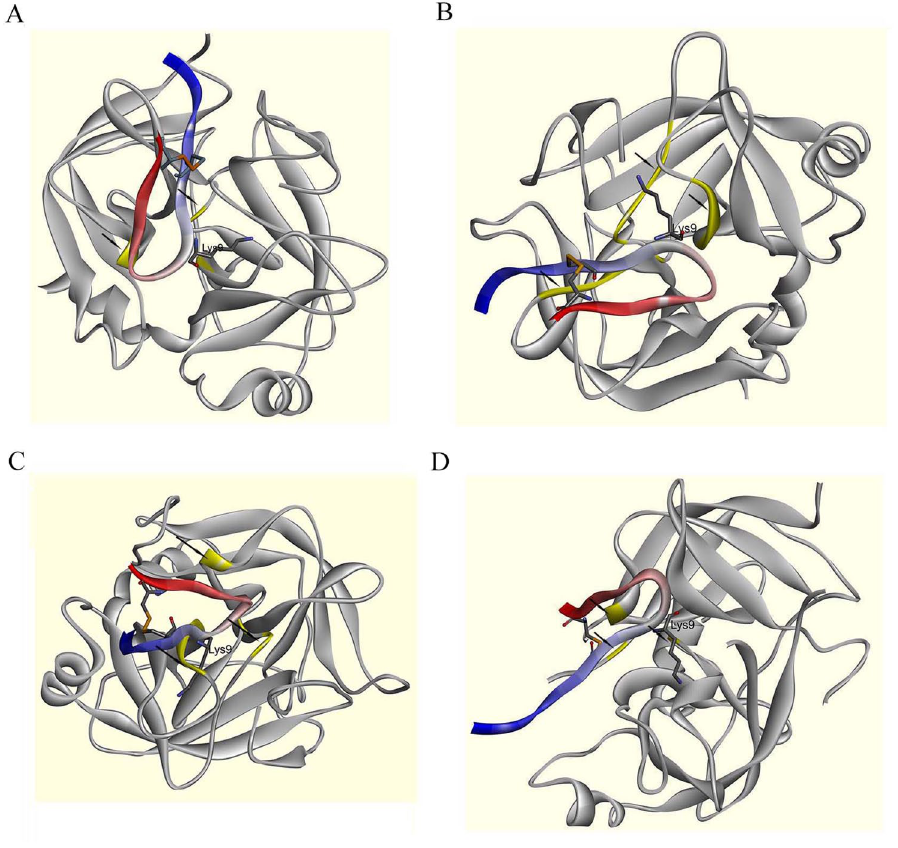
Figure 5. Structural characteristics of the protease-inhibitor docking output for PE-BBI and KLKs. The secondary structure of PE-BBI was labelled (N-terminal is blue and C-terminal is red), and the active site (Lys 9 ) was shown in stick representation. The disulphide bond was showed in stick representation (Orange). The active site of KLKs were labelled with arrows and highlight (Yellow). ( A) Possible interactions model between PE-BBI and KLK4. (B) Possible interactions model between PE-BBI and KLK6. (C) Possible interactions model between PE-BBI and KLK8. (D) Possible interactions model between PE-BBI and KLK10.